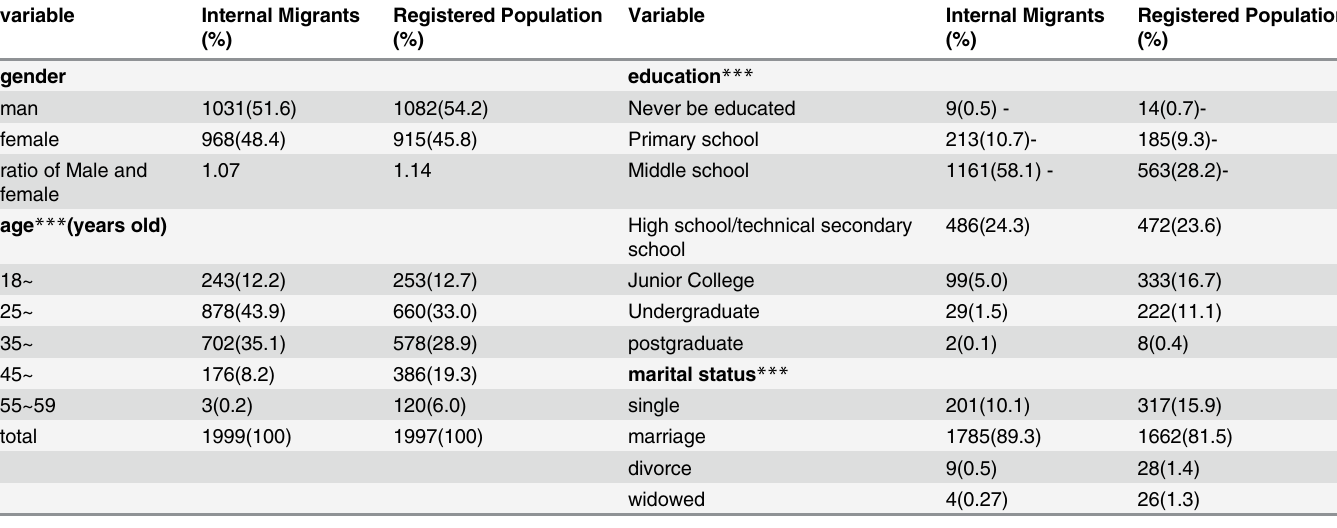
Table 1. Respondent ’ s Socio-demographic Characteristics in ZhongShan in